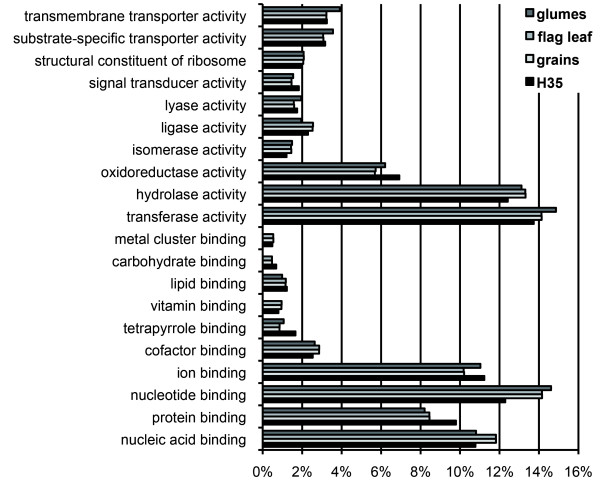
Blast2GO annotation of RNA-seq contigs and H35 unigenes. The result is based on gene ontology terms level 3 of the category Molecular Function. 21,525 sequences from flag leaves, 10,361 sequences from glumes, 21,199 sequences from grains and 22,043 sequences from the H35 database were annotated.